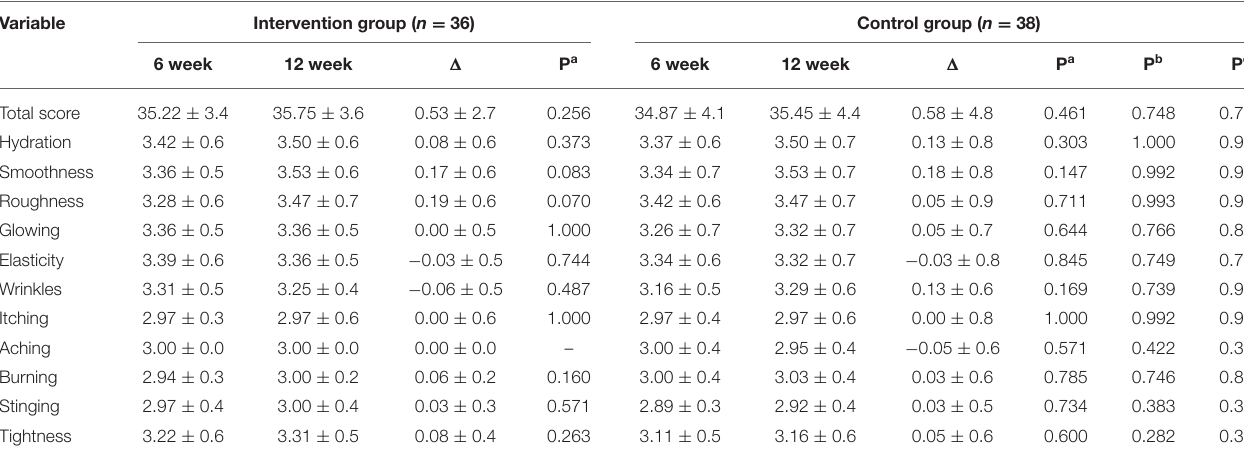
TABLE 4 | Self-assessment of skin texture in per protocol analysis.